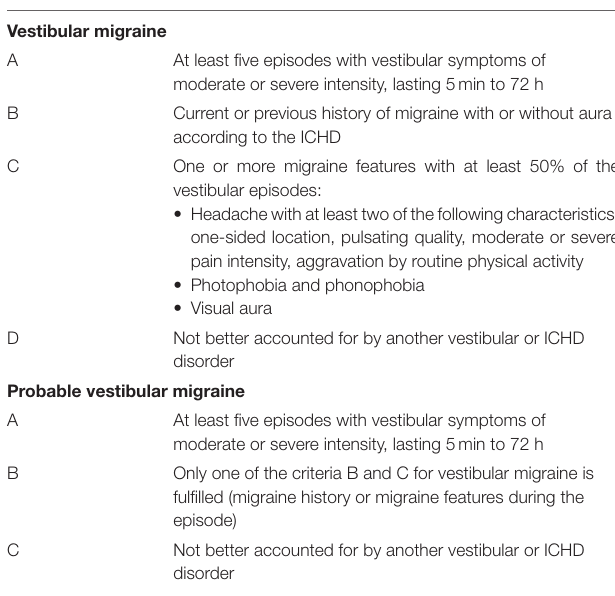
FIGURE 1 | Flow diagram of patient selection, exclusion, and research